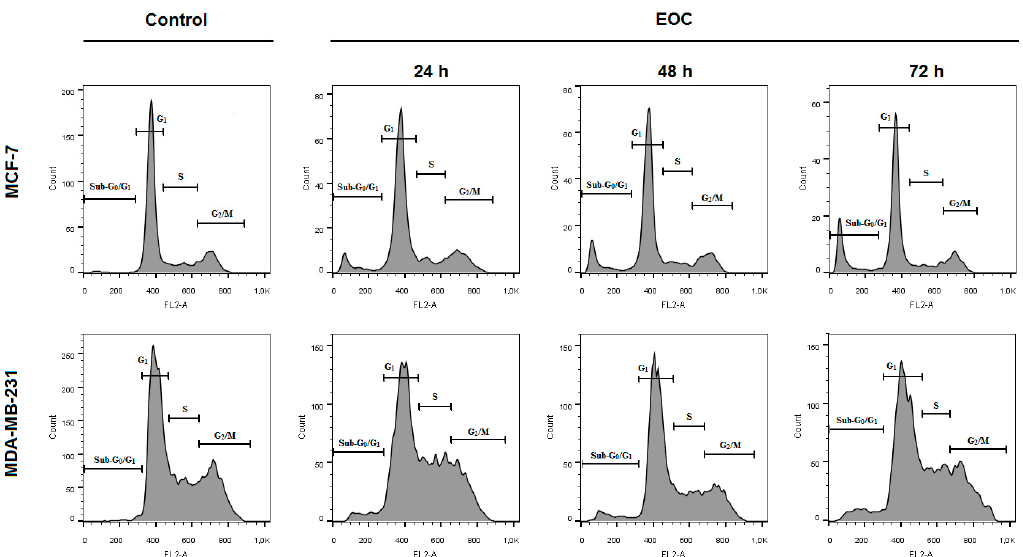
Figure 10. Representative diagrams of cell cycle distribution in MCF-7 and MDA-MB-231 cells after EOC treatment (1:25,000, 1:65,000).